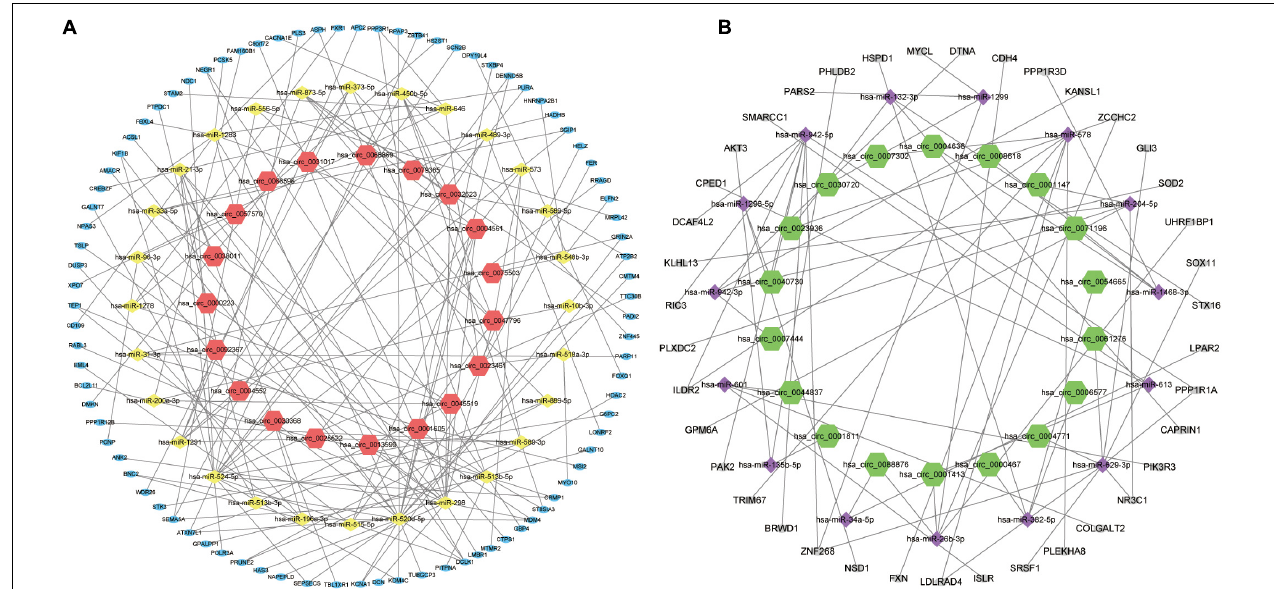
FIGURE 4 | circRNA-miRNA-mRNA regulatory Network of AMI. (A) Up-regulated circRNA corresponding circRNA-miRNA-mRNA regulatory Network. (B) Down-regulated circRNA corresponding circRNA-miRNA-mRNA regulatory Network. For panels (A,B) , the orange-red regular hexagon represents up-regulated circRNA, the green regular hexagon represents down-regulated circRNA, the yellow diamond represents down-regulated miRNA, the purple diamond represents up-regulated miRNA, the blue oval represents up-regulated mRNA and the gray oval represents down-regulated mRNA.